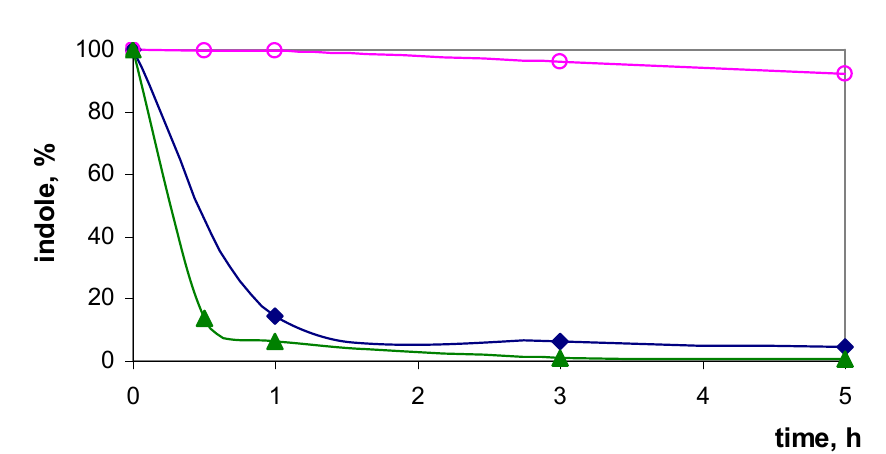
Fig. 6 Alkylation of indole potassium salt with 1-bromobutane in different ionic liquids (at 25 ◦ C in: a) (cid:3) – [bmim][Br]; b) (cid:2) – [mmim][OTs]; c) ◦ –